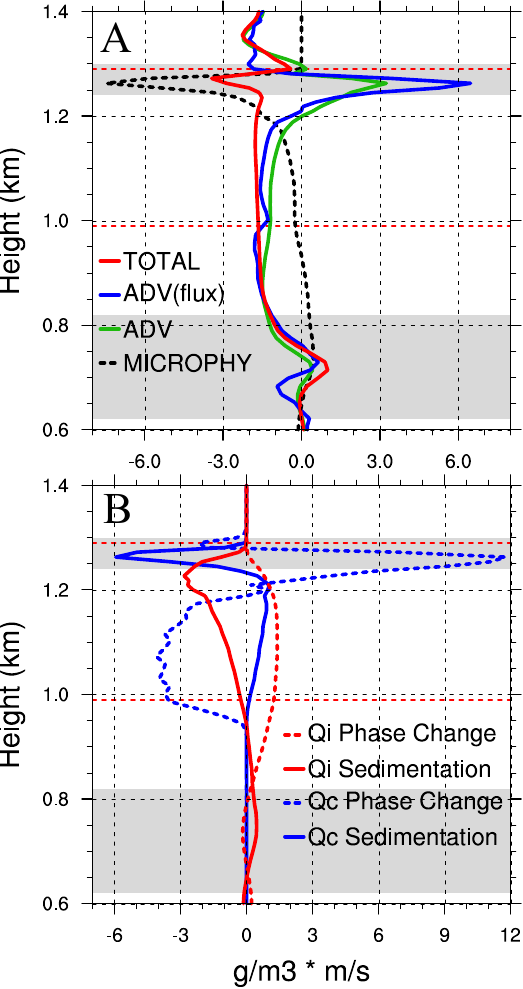
Fig. 13. (A) Processes that contribute to 15-min averaged total wa- ter content tendencies above the surface layer for the square box, in units of gm − 3 day − 1 . Note that the net contribution due to mi- crophysics for total water (MICROPHY) is equal to sedimentation, as condensational terms cancel. “ADV(flux)” is total flux estimated using Eq. (6). “ADV” is total advection output from the model. “TOTAL” is total water tendency. Entrainment zones indicated with gray shading. (B) Cloud liquid water and ice microphysical tenden- cies divided into contributions due to phase change and sedimenta- tion, in units of gm − 3 day − 1 . Cloud layer top and base indicated by red dashed